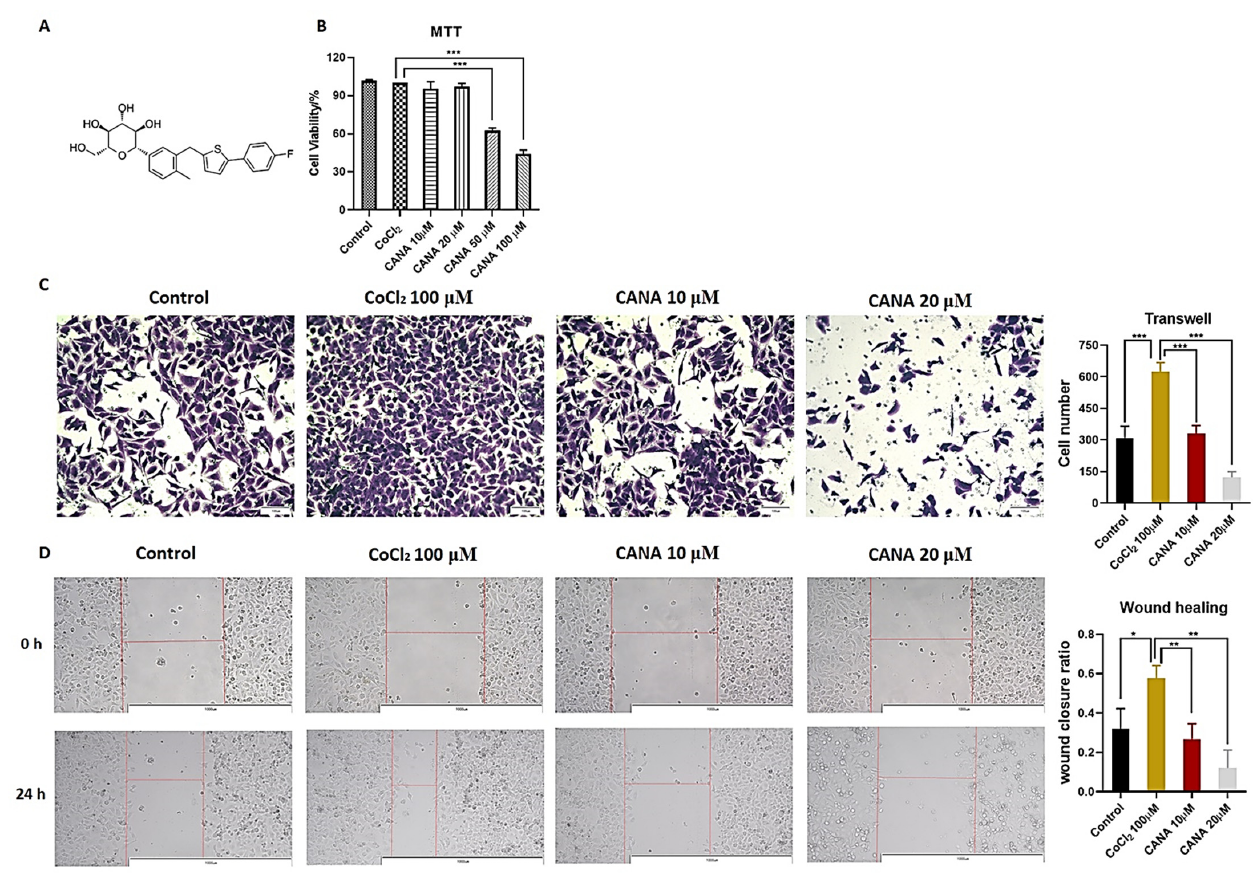
Figure 1. CANA inhibited hypoxia-induced metastasis. ( A ) Chemical structure of CANA. ( B ) Cytotoxic effects after chemical hypoxia (CoCl 2 100 µ M) and CANA (0–100 µ M) intervention for 24 h were evaluated by MTT assay. Transwell (200X) ( C ) and wound healing assays (100X) ( D ) were performed to determine the migration of HepG2 cells. Data were shown as means ± S.D. ( n = 3); * p < 0.05, ** p < 0.01, and *** p < 0.001. Control, normal untreated control; CANA, CANA-treated CoCl 2 (100 µ M)-induced group.